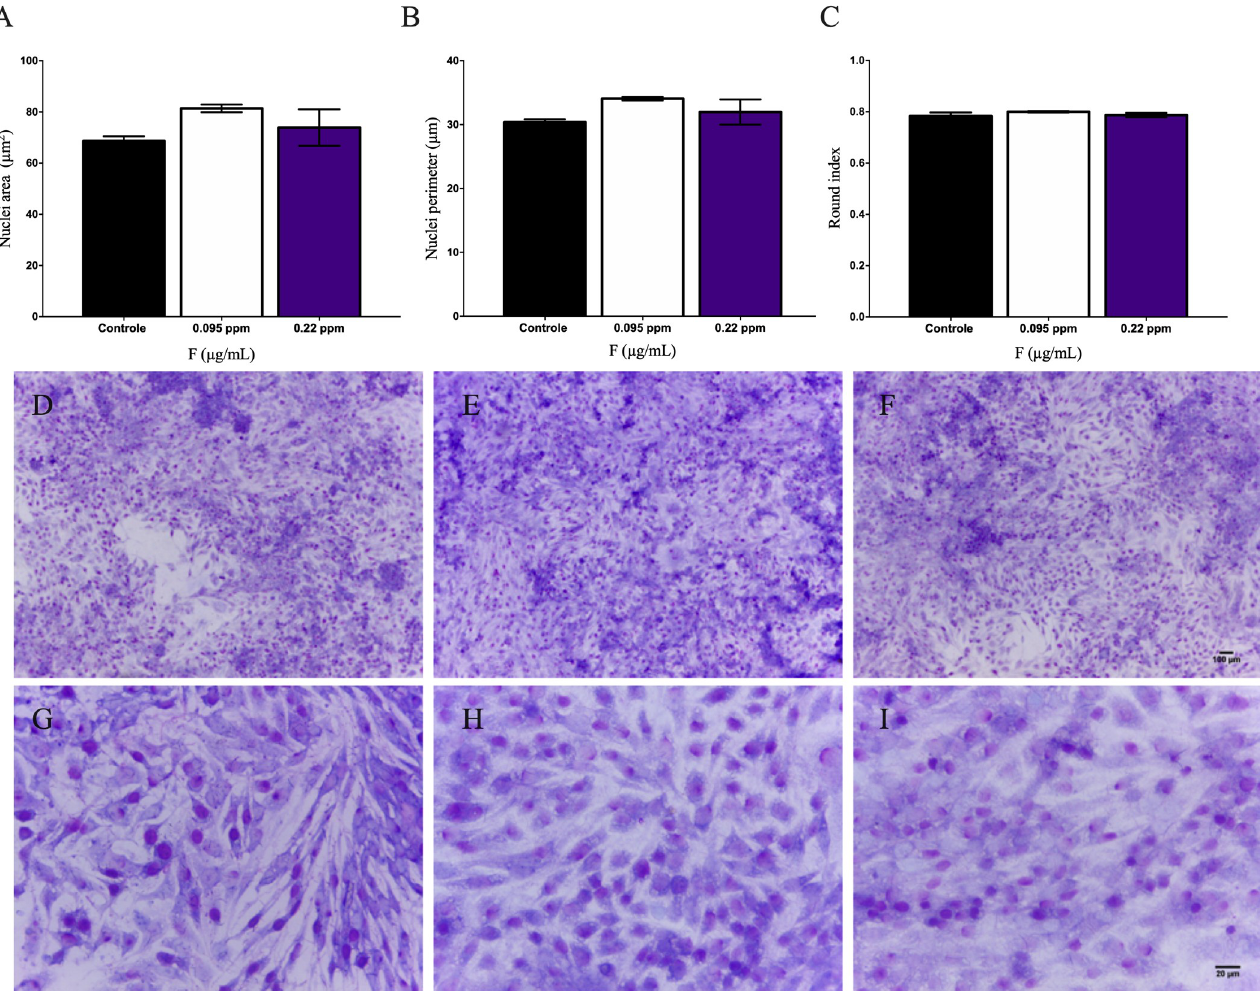
Fig 4. IMR-32 cells morphometric analyses after 10 days of F exposure to 0.095 and 0.22 μ g/mL. Cells were stained by 10% Giemsa and cellular morphology was observed under inverted phase contrast microscope and photomicrography were analyzed by ImageJ. The following parameters were evaluated: A) Nuclei area B) nuclear perimeter and C) rounded index were evaluated. Photomicrography of control (D and G), 0.095 μ g/mL (F and H) and 0.22 μ g/mL (F and I). Data were expressed as mean ±